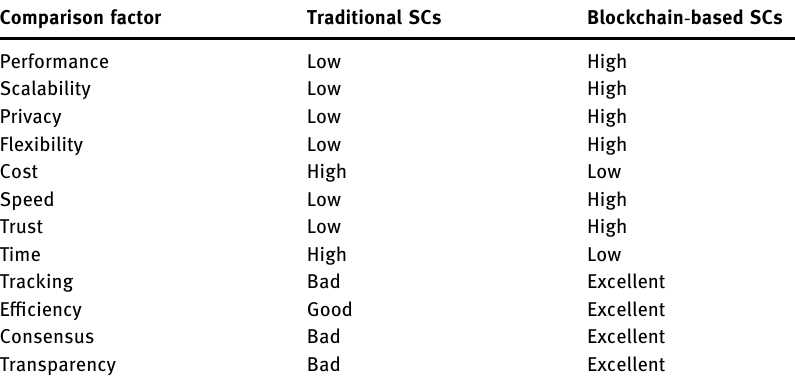
Table 3: Comparison between the traditional SC management and blockchain - based